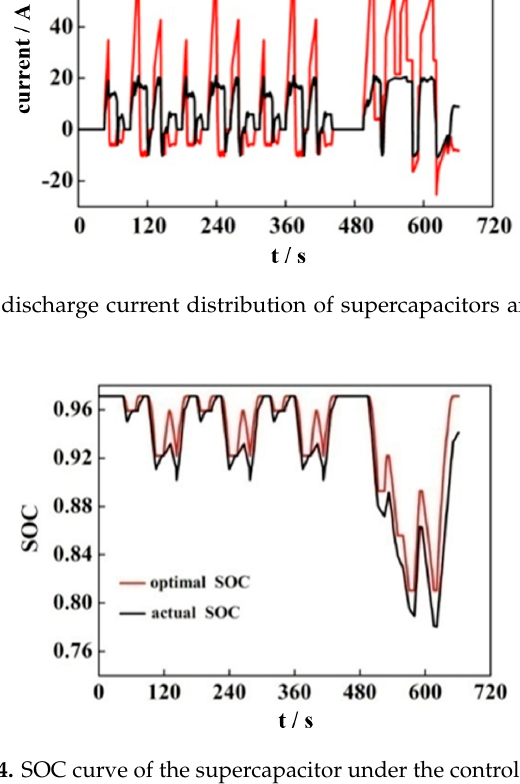
Figure 14. SOC curve of the supercapacitor under the control strategy.